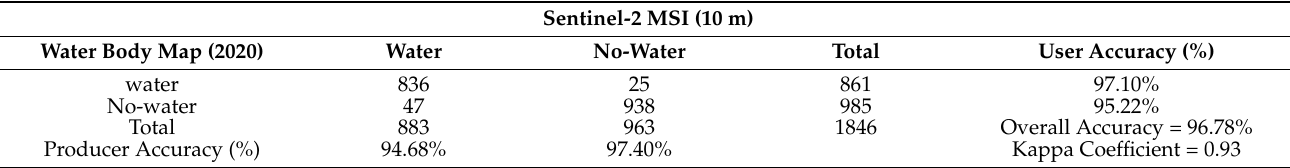
Table 2. Accuracy of the extracted surface water in this